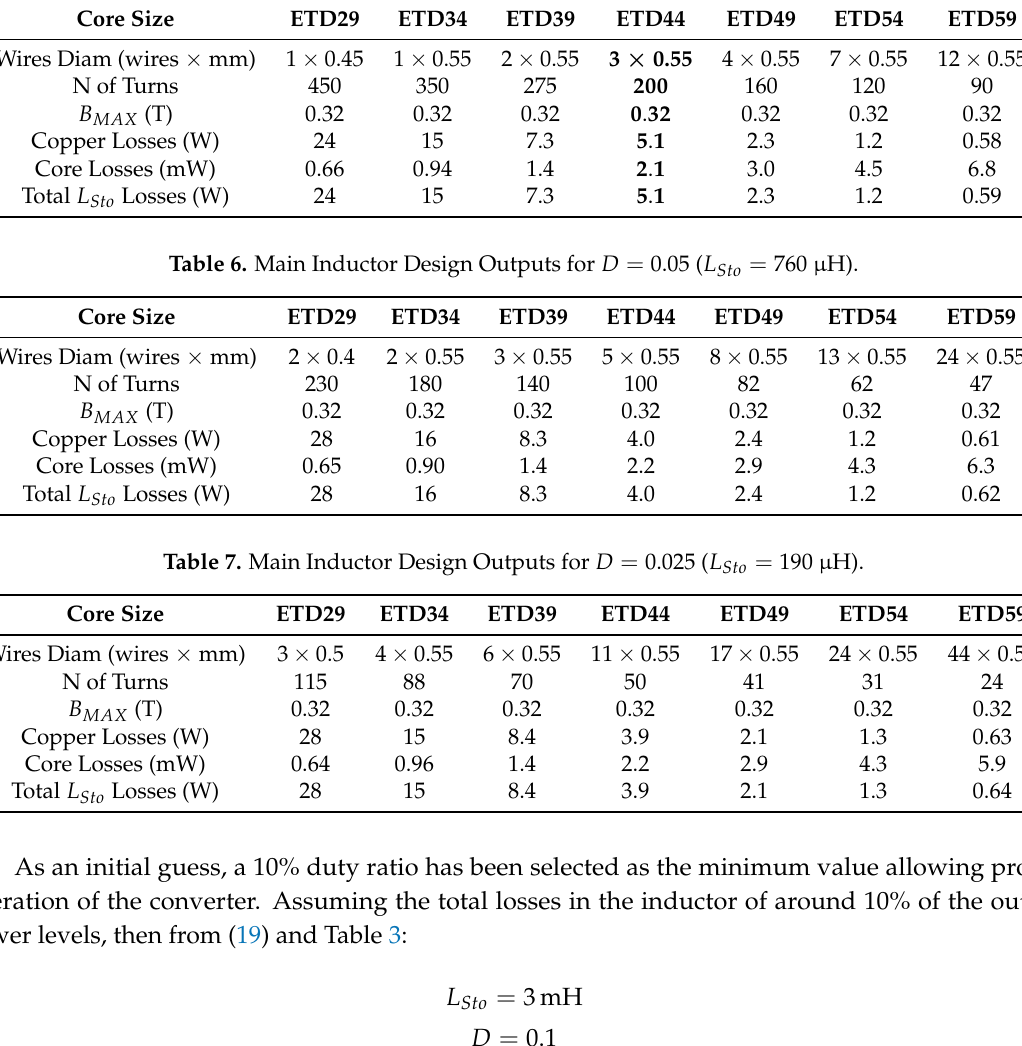
Table 5. Main Inductor Design Outputs for D = 0.1 ( L Sto = 3 mH).